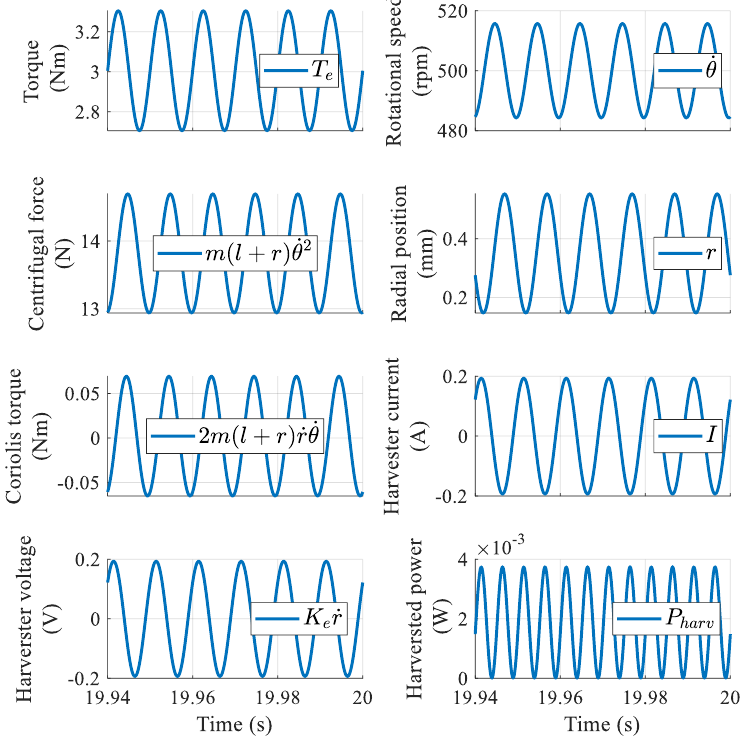
Figure 3. Numerical verification of power